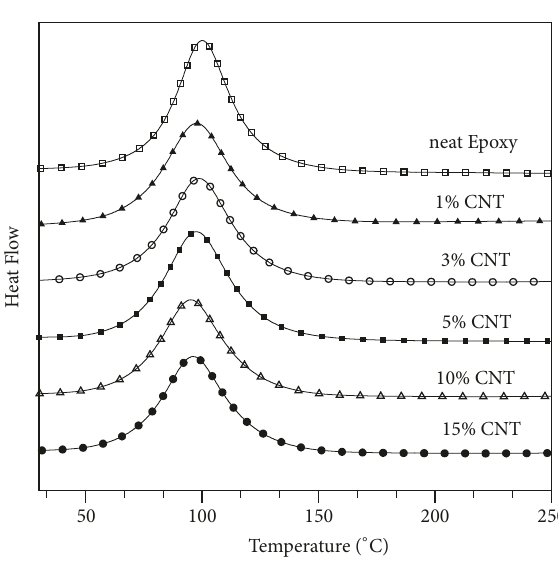
Figure 6: DSC curves of 0, 1, 3, 5, 10, and 15% Weight of SWCNT- epoxy nanocomposites.